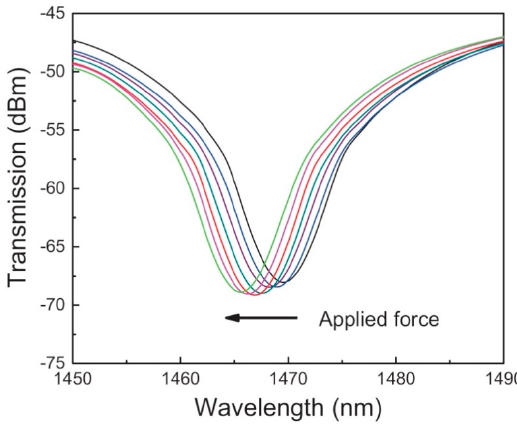
Figure 15. Force-induced wavelength shift of the MCF sensing device [137].